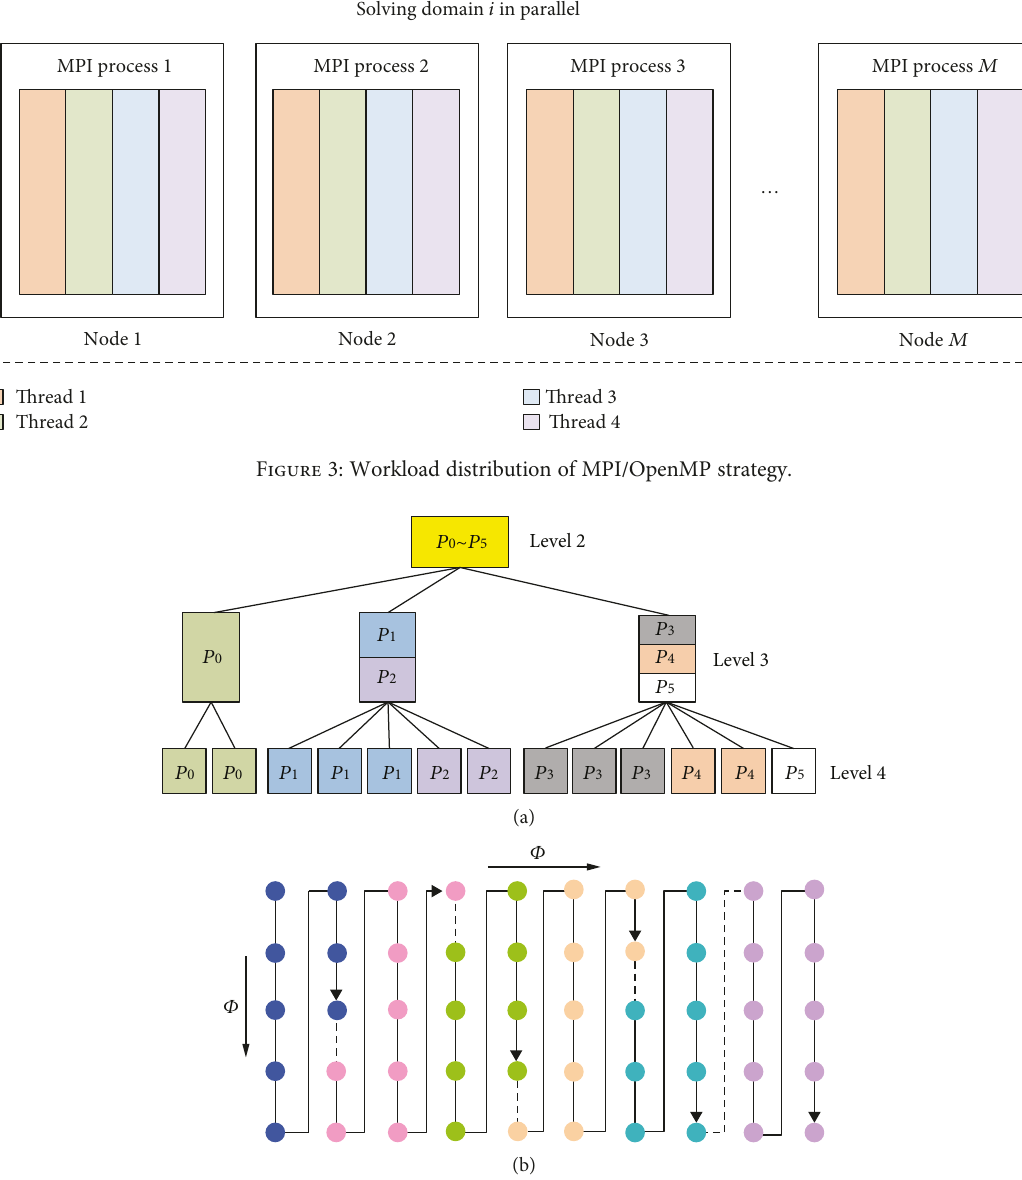
Figure 4: Data distribution of AdP. (a) Tree partitioning scheme and (b) plane-wave direction partitioning scheme in level